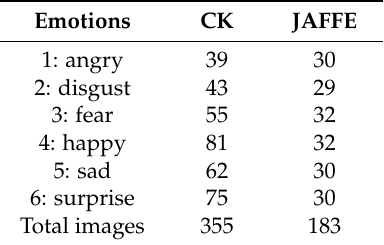
Table 6. Sample size of each emotion on CK and JAFFE